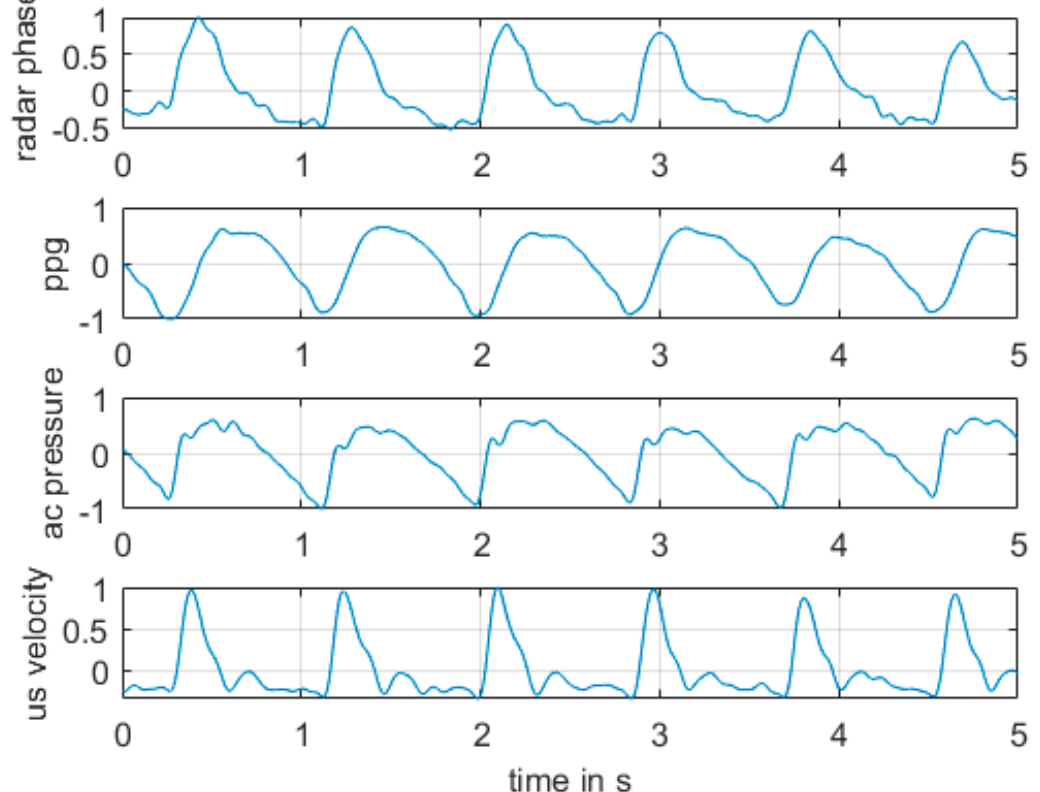
Figure 7. Results for measurement according to Figure 6. All shown measurement signals are normalized to 1. From top to bottom: phase between radar signals I and Q; photoplethysmographic signal 1; ac pressure signal in cuff; ultrasound velocity signal. Bandpass filter Chebyshev type 1 with order 6 infinite impulse response and passband 0.5 Hz–10 Hz was applied to all signals.